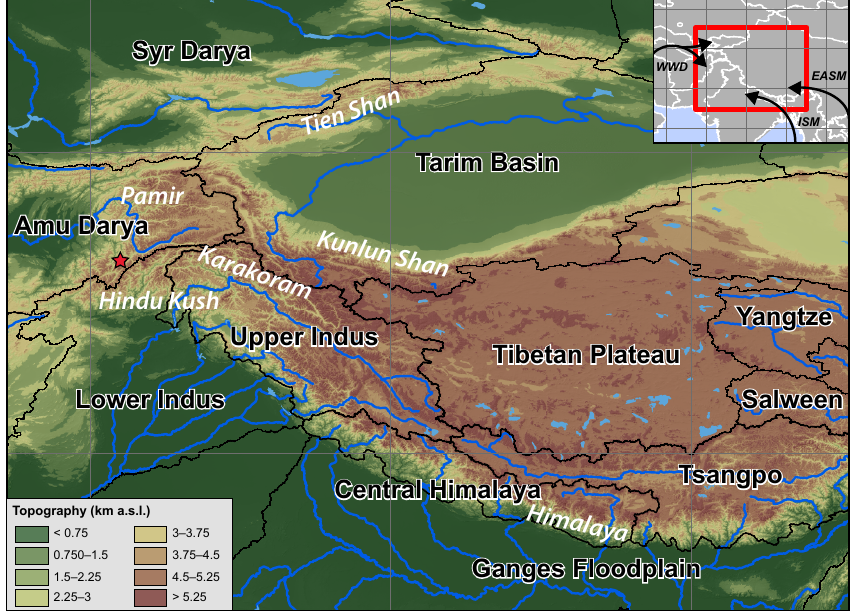
Figure 1. Topographic map of the study area across High Mountain Asia (HMA), with major catchment boundaries (black lines and labels in black font with white border) and major mountain ranges (white font). Inset map shows wind direction of major Asian weather systems (WWD: winter westerly disturbances; ISM: Indian summer monsoon; EASM: East Asian summer monsoon) on top of political boundaries. Red star indicates the location used for Figs. 2 and